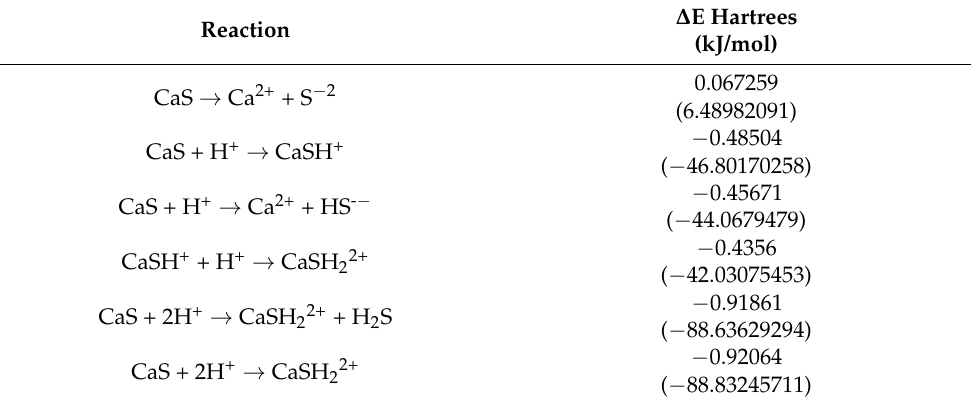
Table 4. Change in energy for reactions associated with the chemistry of CaS nanoclusters in acidic media. Energy differences ( ∆ E) are reported in hartrees. The values in parenthesis represent the energy differences in